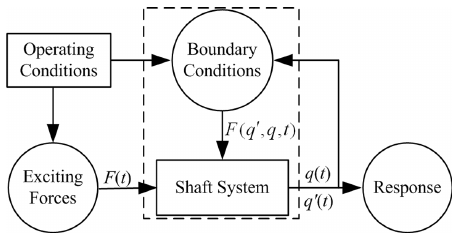
Fig. 2. Logic structure of radial vibration simulation model.